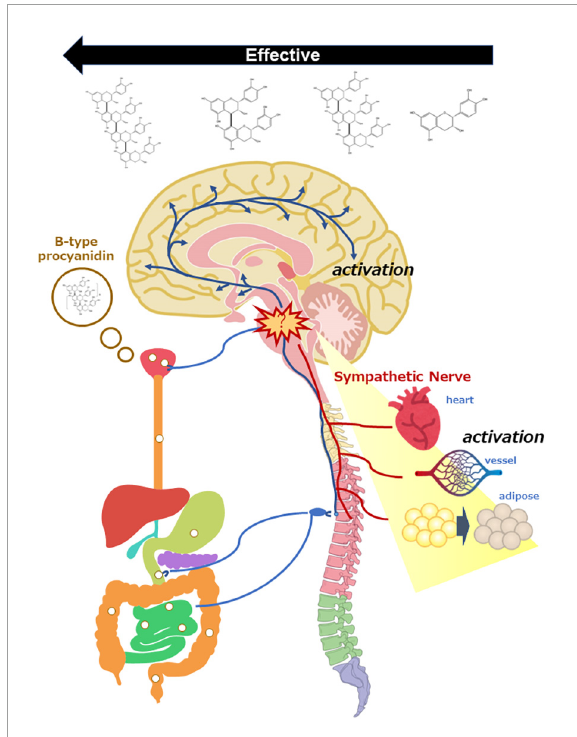
FIGURE2 Scheme of sympathetic nerve activation by oral administration of B-type procyanidins, consequently activation of the central nervous system and peripheral